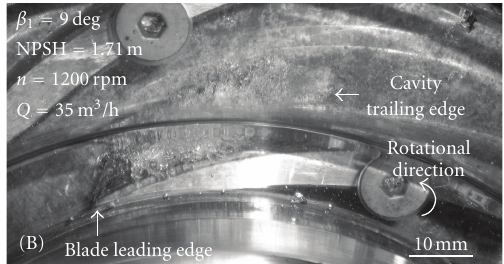
Figure 13: Illustration of cavitation for the blade leading edge angle of 9deg and NPSH equal to 1.71 m.